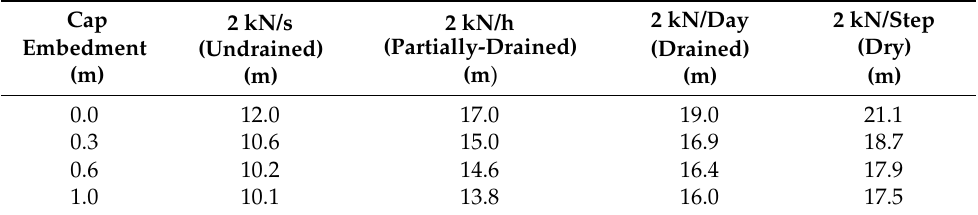
Figure 4. Effect of cap embedment depth on lateral displacement of pile cap: ( a ) undrained (loading rate = 2 kN/s); ( b ) partially drained (loading rate = 2 kN/h); ( c ) drained (loading rate = 2 kN/day); and ( d ) dry soil (loading rate = 2 kN/step). Table 3. Effect of pile cap embedment depth on lateral displacement of pile cap under various loading conditions and in dry